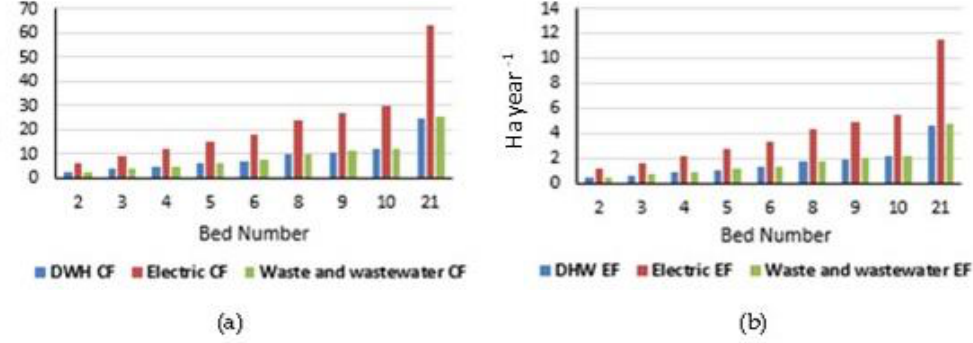
Figure 7. ( a ) Carbon footprint before implementing renewable energy of DHW, electric consump- tion and organic waste and wastewater production; ( b ) ecological footprint before implementing renewable energy of DHW and electric consumption and organic waste and wastewater production. From the data obtained, CF of rural tourism represent approximately 15 tCO 2-eq per year, considering the consumption of DWH, electricity consumption and the generation of waste and wastewater and an EF of approximately 7.5 ha year −1 , and considering that rural tourism is expanding, it is important to reduce its carbon and ecological footprint.